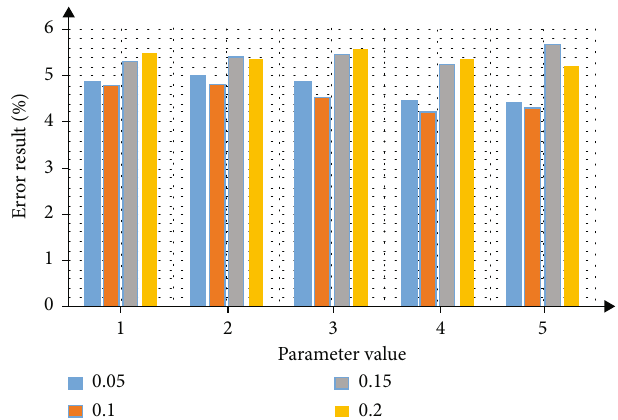
Figure 8: Error results under di ff erent parameters.